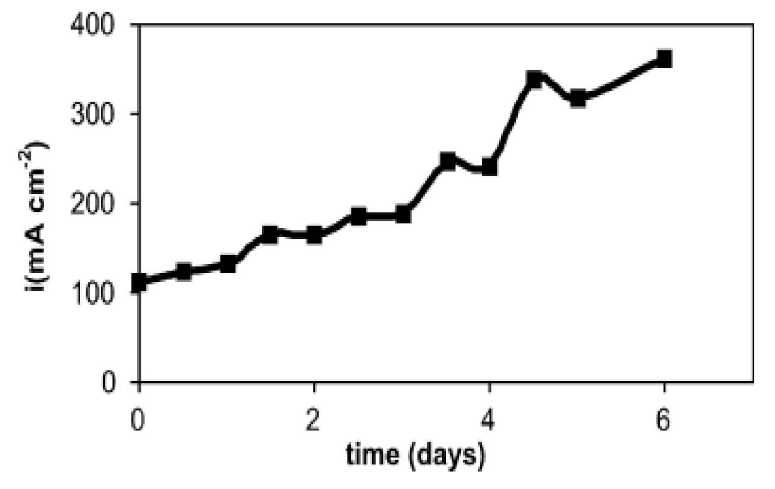
Figure 16. The plot of current density vs. time of a SOFC with Co-YSZ anode with 10% ( v / v ) H 2 S/CH 4 at 0.5 V and 850 ◦ C (adapted from